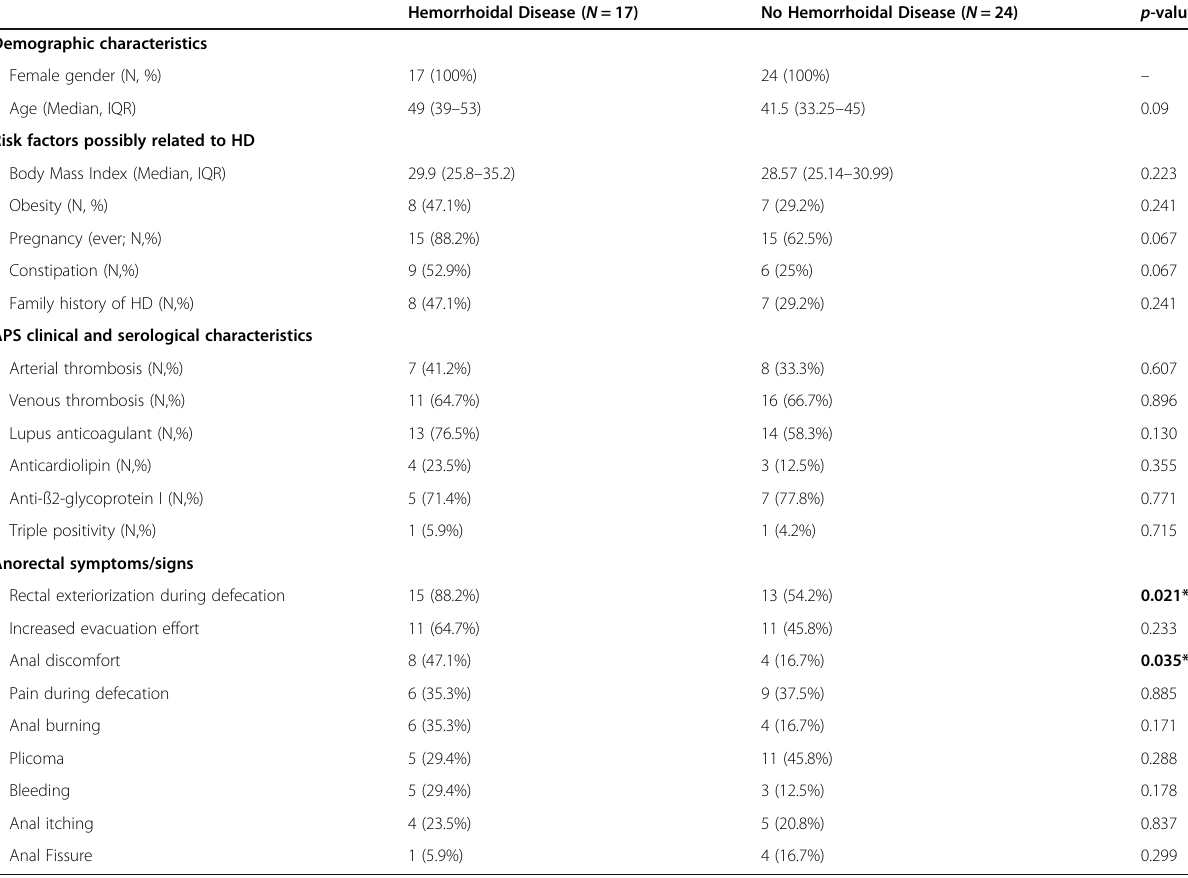
Table 1 Clinical and laboratory characteristics of APS patients included, according to HD diagnosis Hemorrhoidal Disease ( N =17) No Hemorrhoidal Disease ( N =24) p